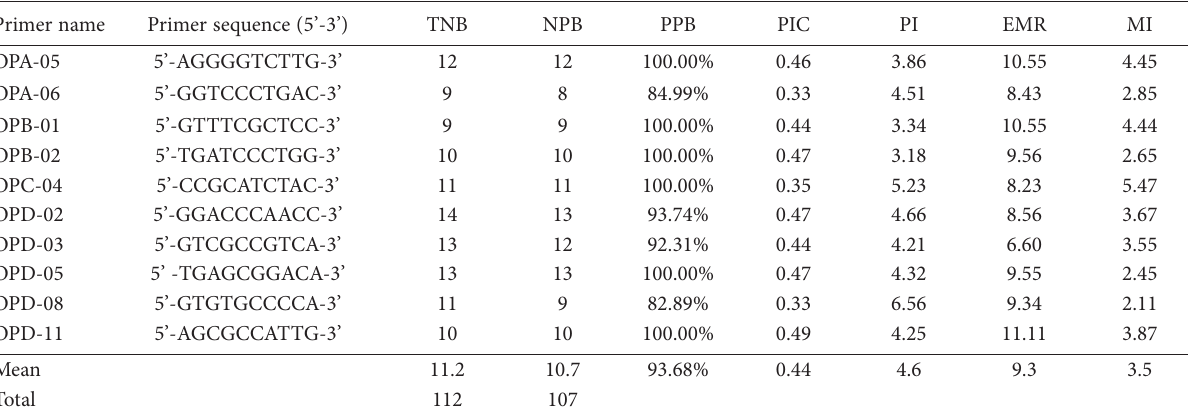
Table 2. RAPD primers used for this study and the extent of